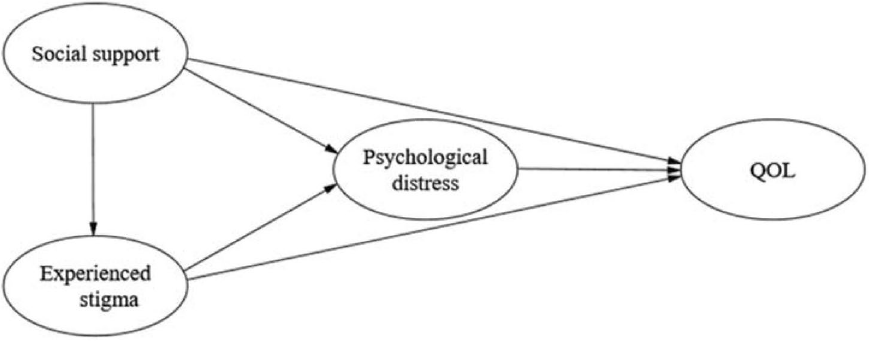
Figure 1. Hypothetical model of relationships among social support, experienced stigma, psychological distress, and QOL. QOL quality of